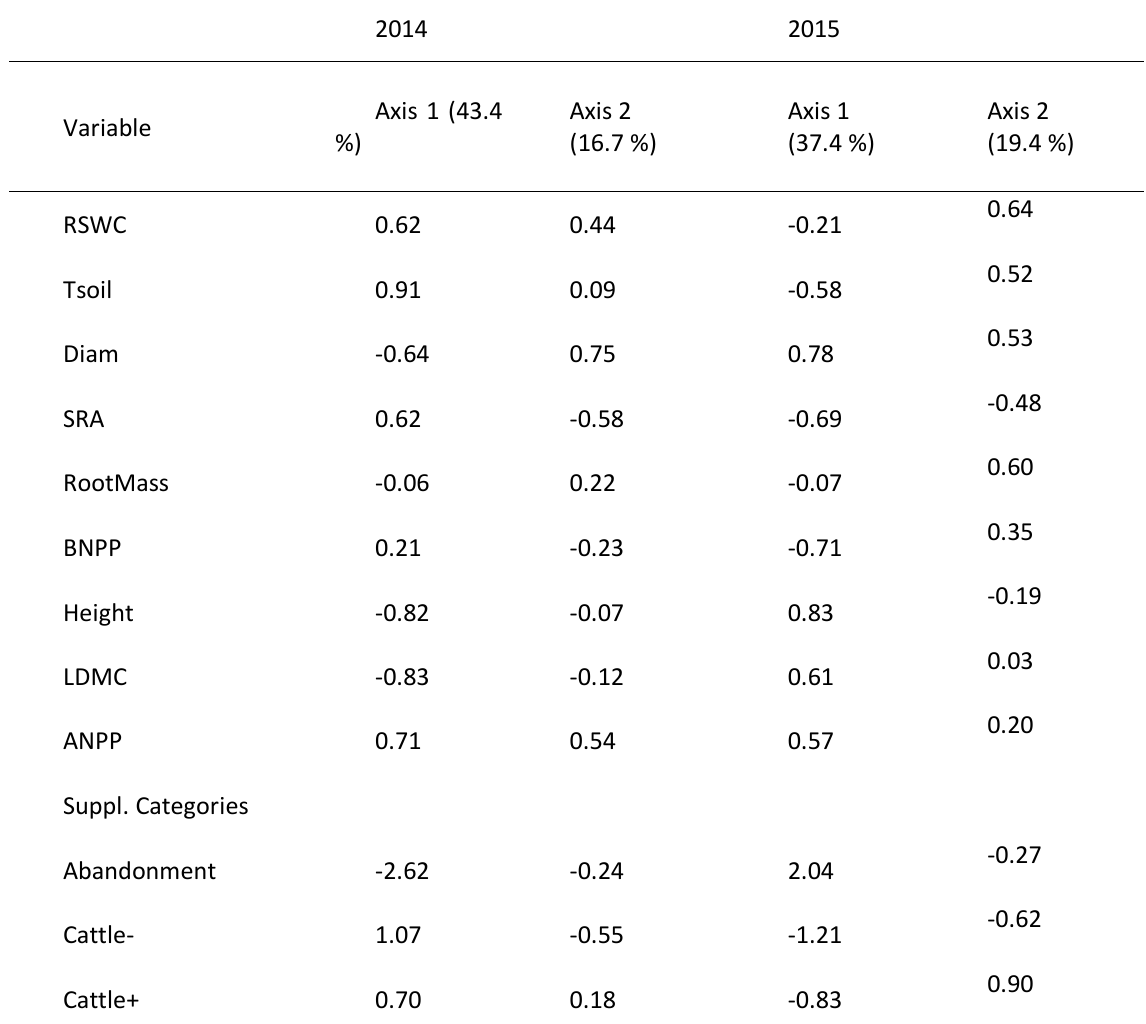
Table 5 . Contribution of the different variables to the first two axes of the principal component analysis (PCA) calculated for 2014 and 2015. Variables used in the PCA were annual relative soil water content (RSWC), annual soil temperature (Tsoil, °C), root diameter (Diam, mm), specific root area (SRA, m 2 g -1 ), root mass averaged over three dates (RootMass, g m -2 ), annual root production (BNPP, g m -2 y -1 ), plant height (Height, cm), leaf dry matter content (LDMC, g g -1 ), annual above-ground production (ANPP, g m -2 y -1 ). Treatments were added as supplementary categories. Contribution in bold indicates significant correlation of the variables on the PCA axis (P <